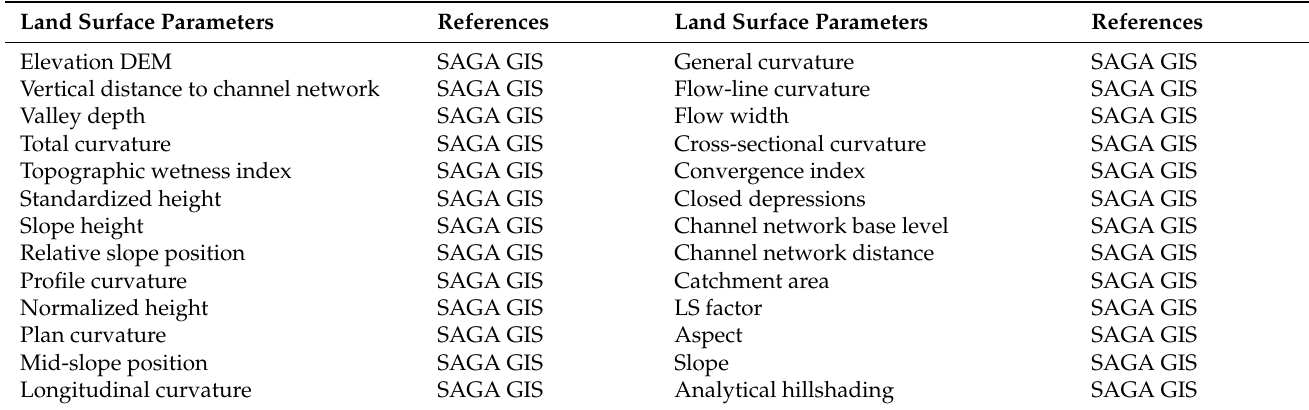
Table 4. Terrain attributes required for the